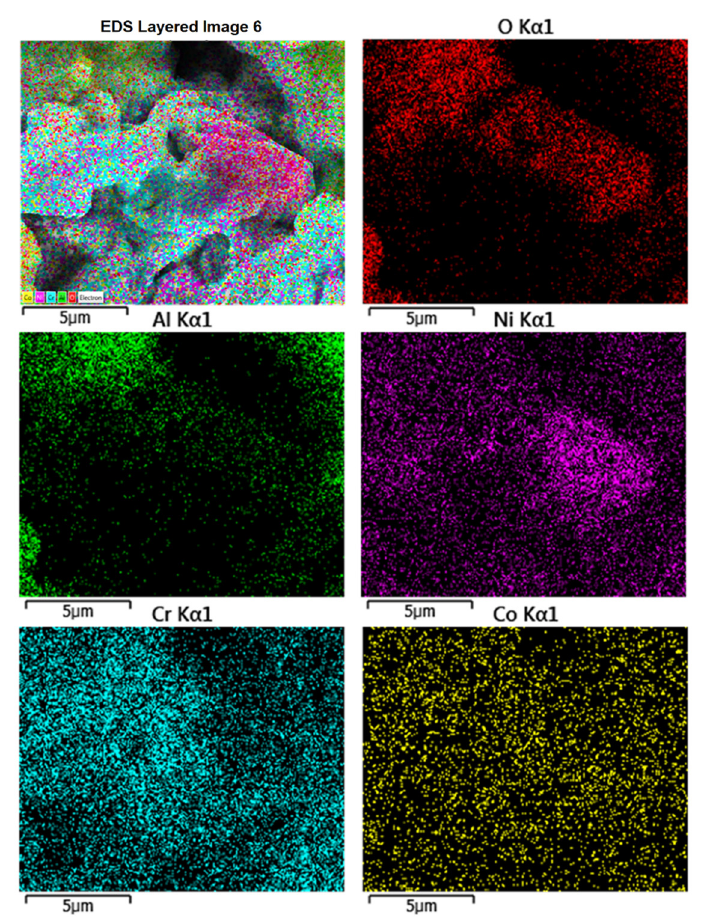
Figure 8. EDS maps of a localized region on the oxidized coating top-surface. The formation of mixed oxide scales composed of Ni, Al and Cr can be